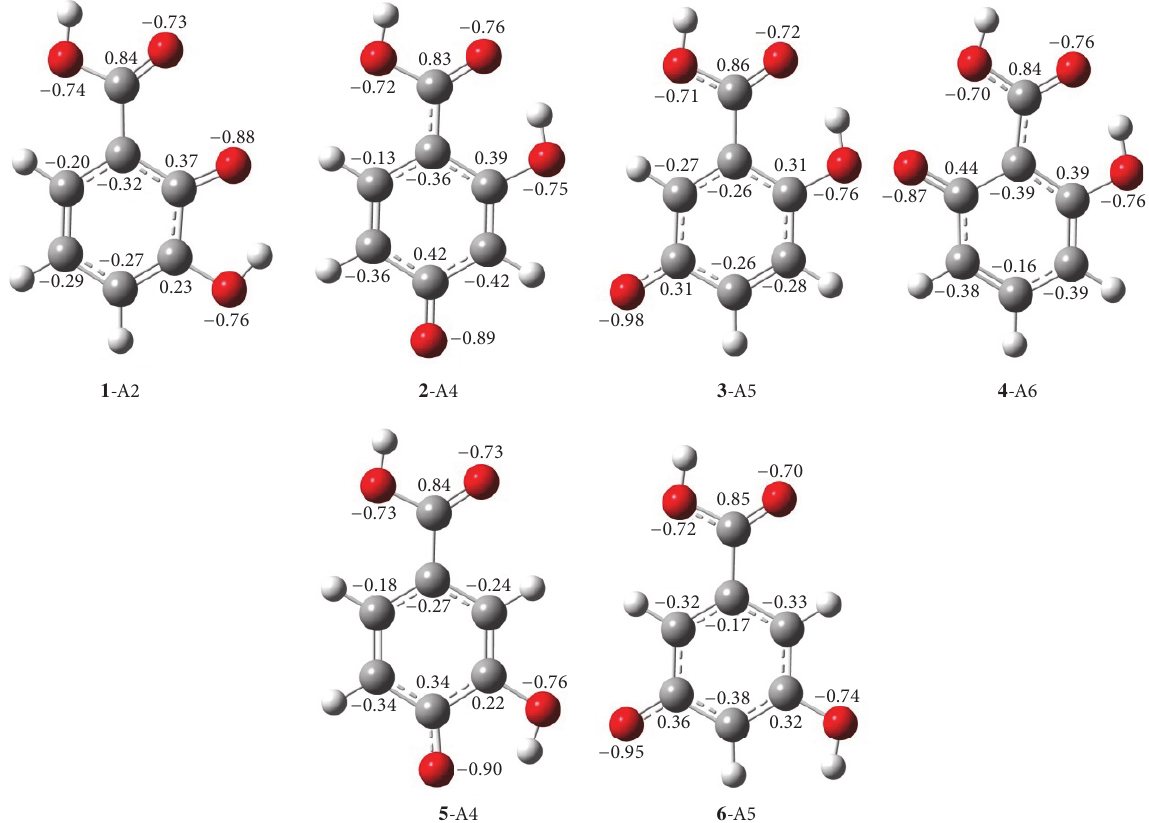
Figure 4: The natural charge distributions in the most stable anions formed from the investigated DHBAs in water.